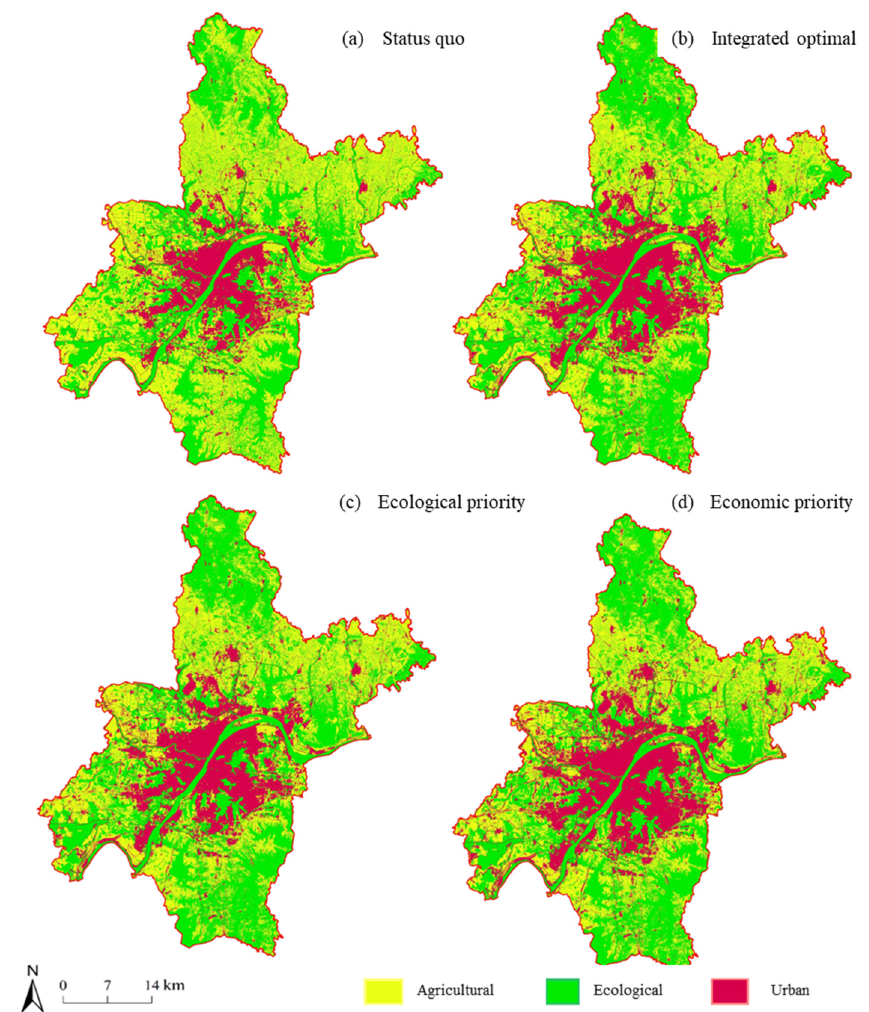
Figure 3. Partial details of optimization results of three types of spatial layout.